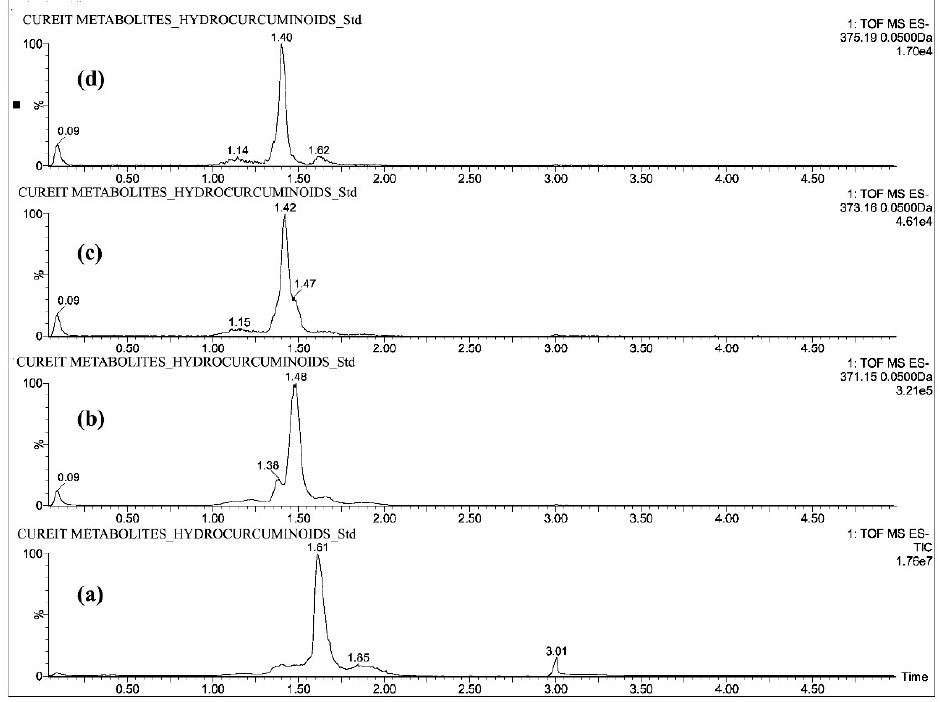
Figure 2. UPLC-QTOF-MS chromatograms of standards—( a ) total ion chromatogram of curcuminoids and COG, extracted ion chromatograms of ( b ) CUR, ( c ) DMC, ( d ) BDMC and ( e ) COG.